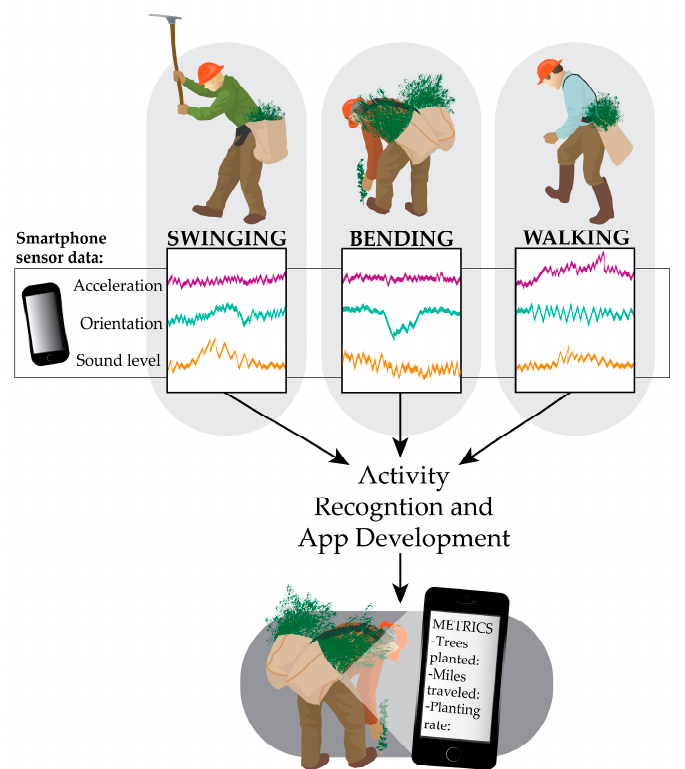
Figure 13. Activity recognition modeling and application, using tree planting as an example. Initial sensor data is collected during completion of specified activities: swinging a hoedad planting tool, bending to place a seedling, or walking to the next site. Patterns in the raw sensor data are used to compute activity recognition, which can then be incorporated into apps for use on mobile devices in the field to quantify work activities, such as number of trees planted. This figure is adapted from Keefe et al. [14].